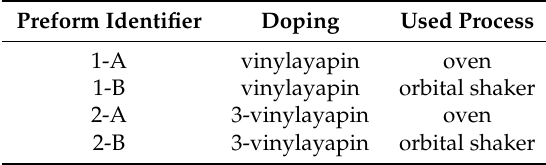
Table 1. Process parameters of the studies